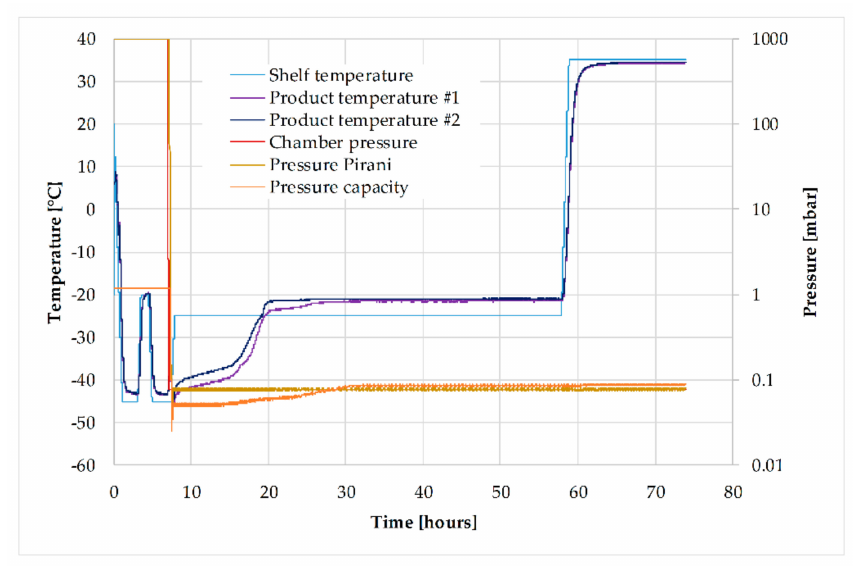
Figure 25. Temperature and pressure course during lyophilization.